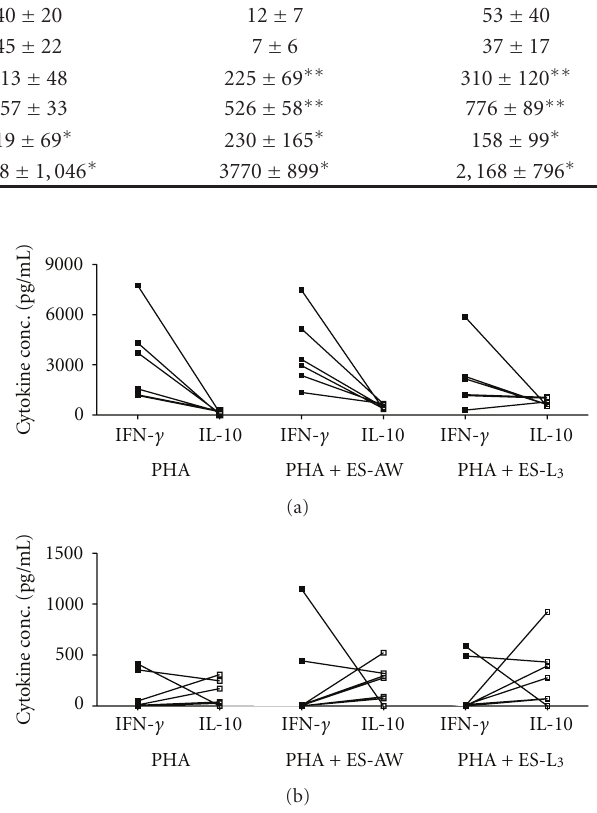
Figure 2: IFN- γ and IL-10 secretion in pg/mL in PBMC stimulated with PHA, PHA+ adult worm ES (ES-AW), or PHA+ ES-L 3 . (a) Paired IFN- γ and IL-10 cytokine concentrations in PBMCs from egg negative, nonendemic controls and (b) in hookworm-infected patients from an endemic